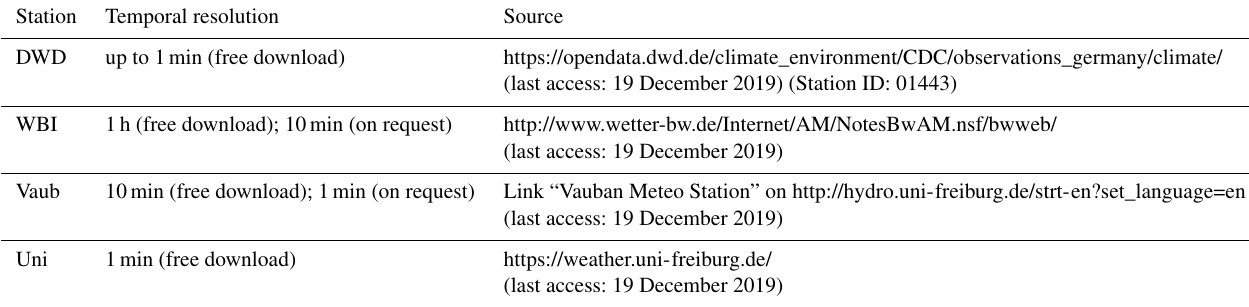
Table 4. Sources of climate data for the study area.